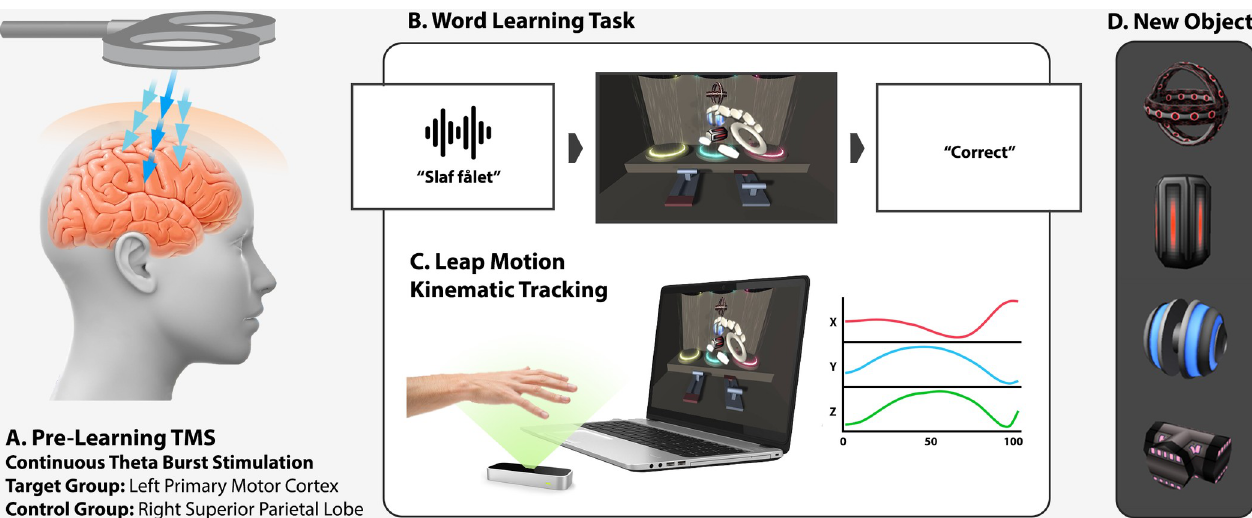
Fig 1. Task design. (A). Two groups of participants underwent 40 seconds of cTBS over either left M1 (primary motor cortex target) or a control site (right superior parietal lobe, subarea 5l) prior to the language learning task. (B). Participants learned new verbs and nouns by playing a 3D computer game in which they used their right hand to interact with objects in the virtual environment. (C). Their learning performance and hand movement kinematics were tracked and quantified throughout using a Leap Motion controller. (D). Illustration of the 4 novel 3D objects. All participants received DKI brain scans directly before and after the language task, as well as after 24 hours, in order to assess learning-induced microstructural remodelling as reflected by diffusion kurtosis changes. cTBS AU : AbbreviationlistshavebeencompiledforthoseusedinFigs 1 (cid:0) 4 : Pleaseverifythatallentriesarecorrect : , continuous theta-burst stimulation; DKI, diffusion kurtosis imaging; TMS, transcranial magnetic stimulation.